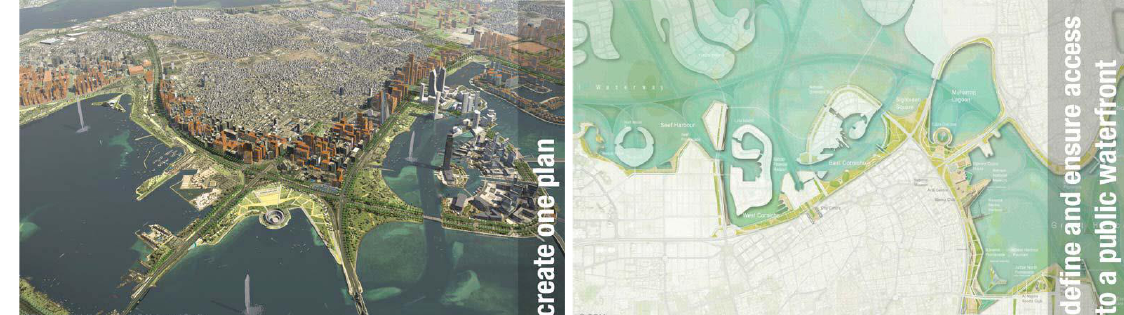
Figure 23: Bahrain’s Masterplan 2030 –